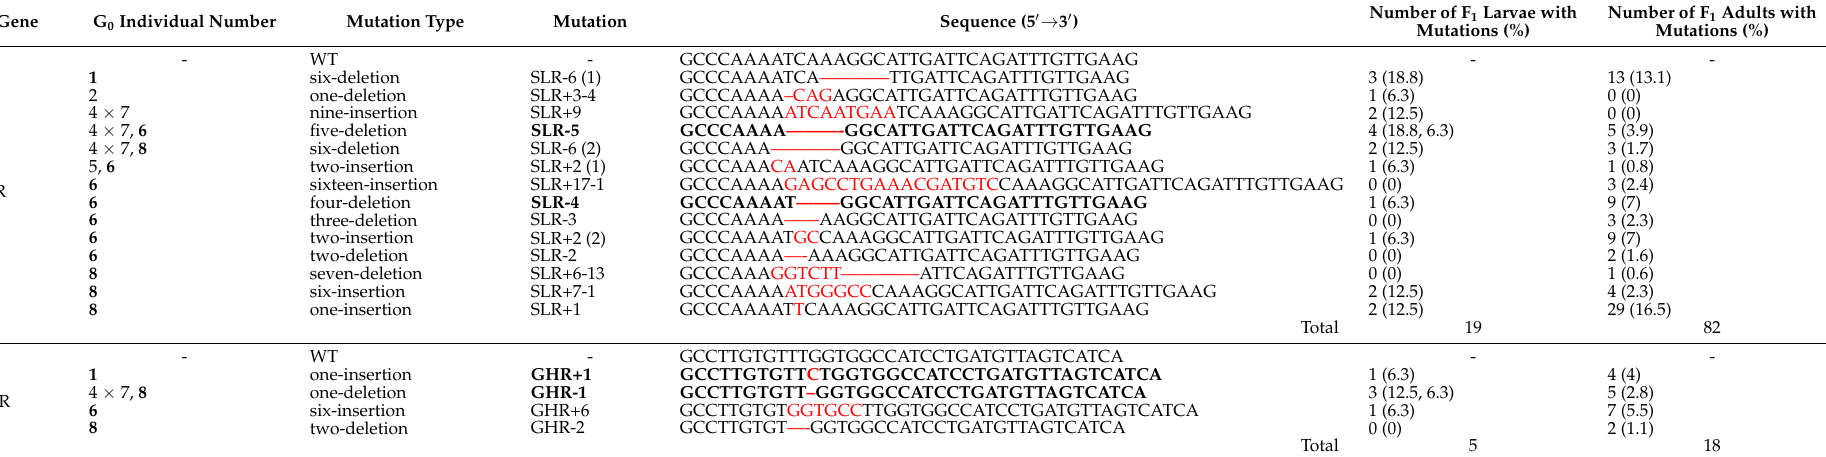
Table 3. Ins/del mutations in SLR and GHR inherited by the F 1 generation from the G 0